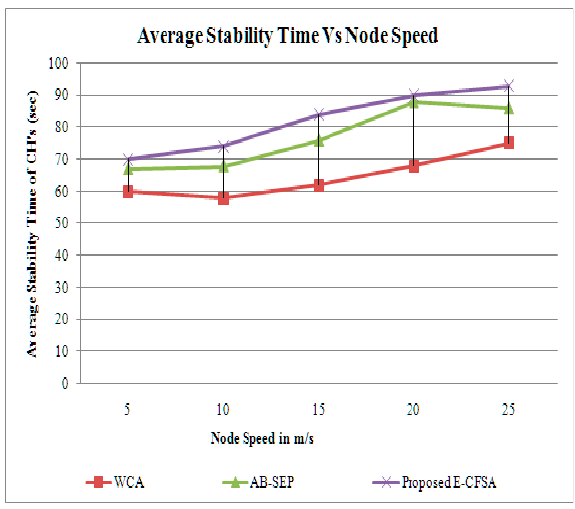
Figure 21. Graph Avg Stability Vs. Node Speed.